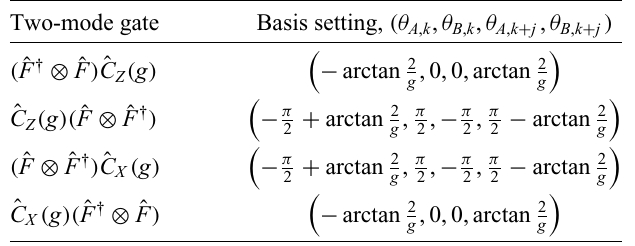
TABLE I. Two-mode gates with input and output in modes